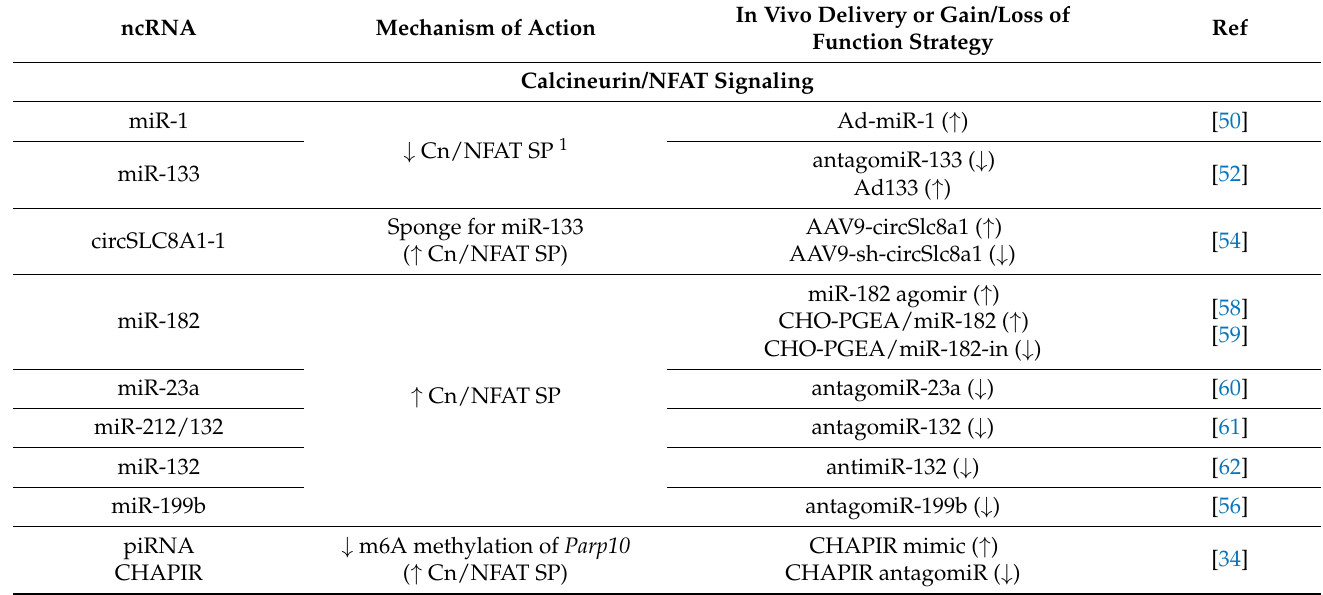
Table 2. ncRNAs involved in specific signaling pathways involved in cardiac